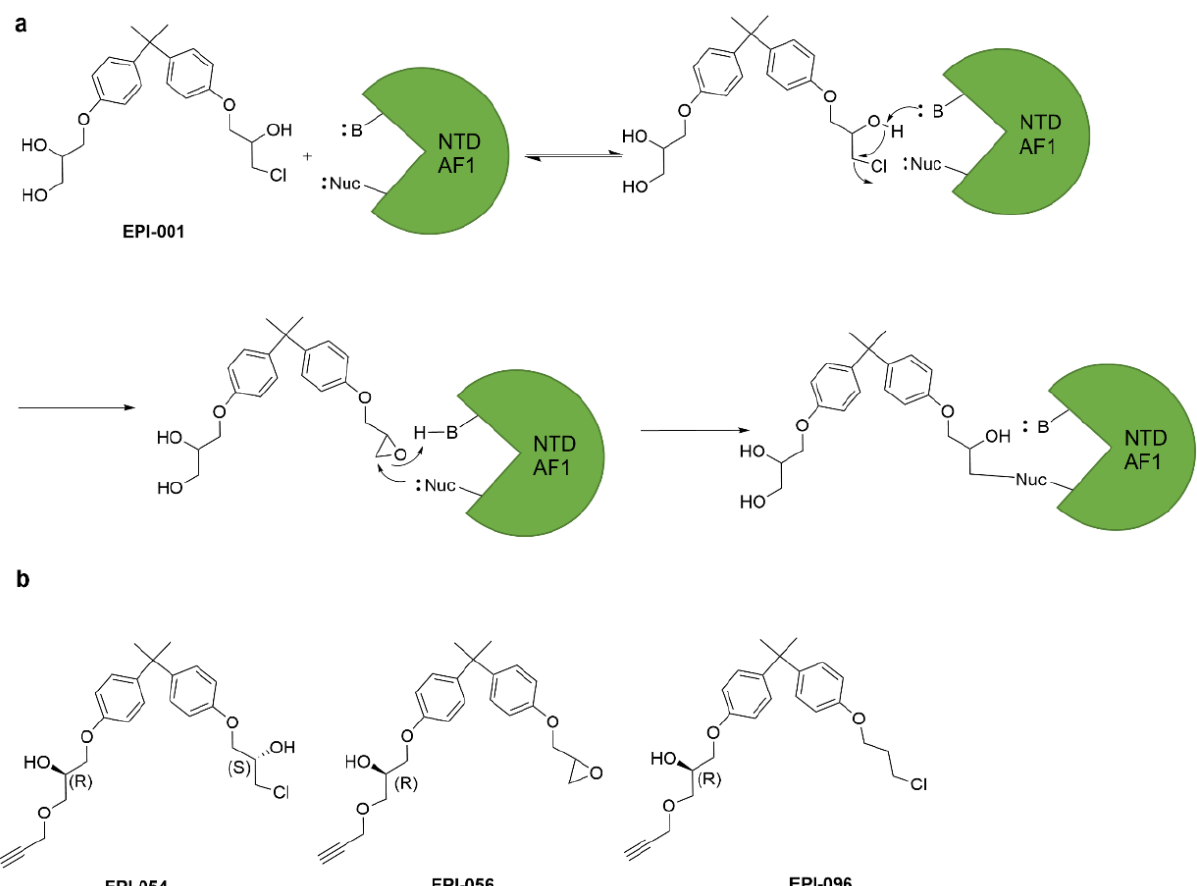
Figure 11. ( a ) Covalent binding reaction of EPI-001 compound to AR AF-1 region. ( b ) Chemical structures of EPI analogs.